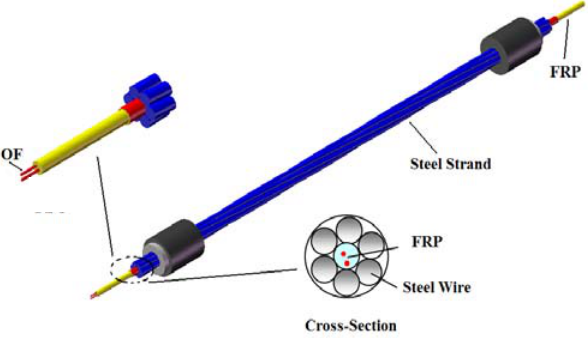
Figure 2. Sketch of smart steel strands structure.